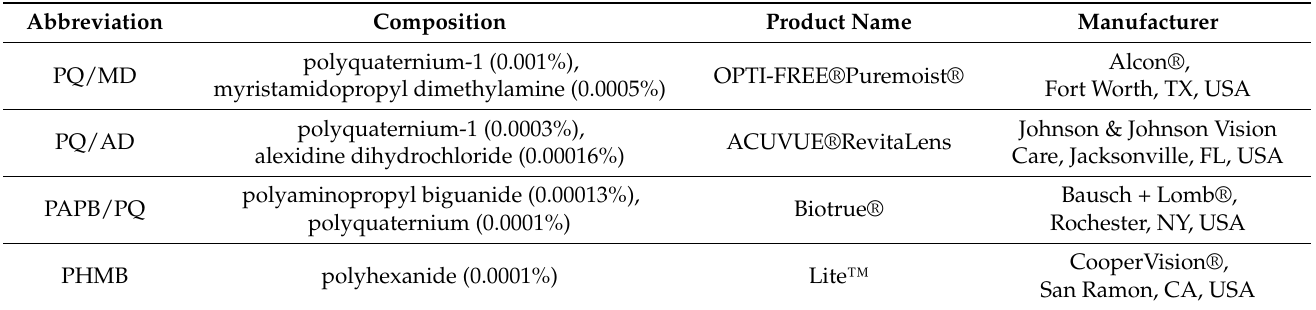
Table 1. Contact lens care (CLC) products used, their abbreviations, compositions, and manufac- turer